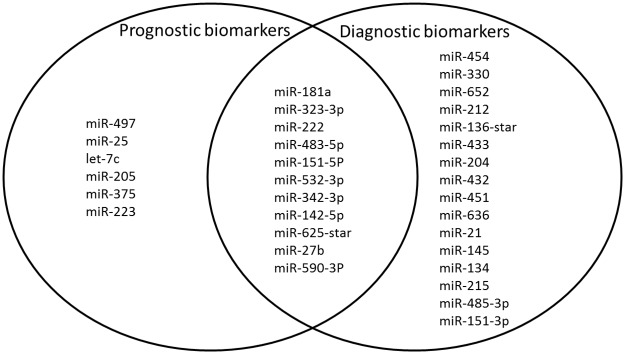
Venn diagram of prognostic and diagnostic miRNA predictors based on the univariate analysis with p<0.05.11 miRNAs were identified as differentially expressed at both time-points; 6 miRNAs were predictive of ß-cell glucose sensitivity at baseline only; and 16 only at follow-up.